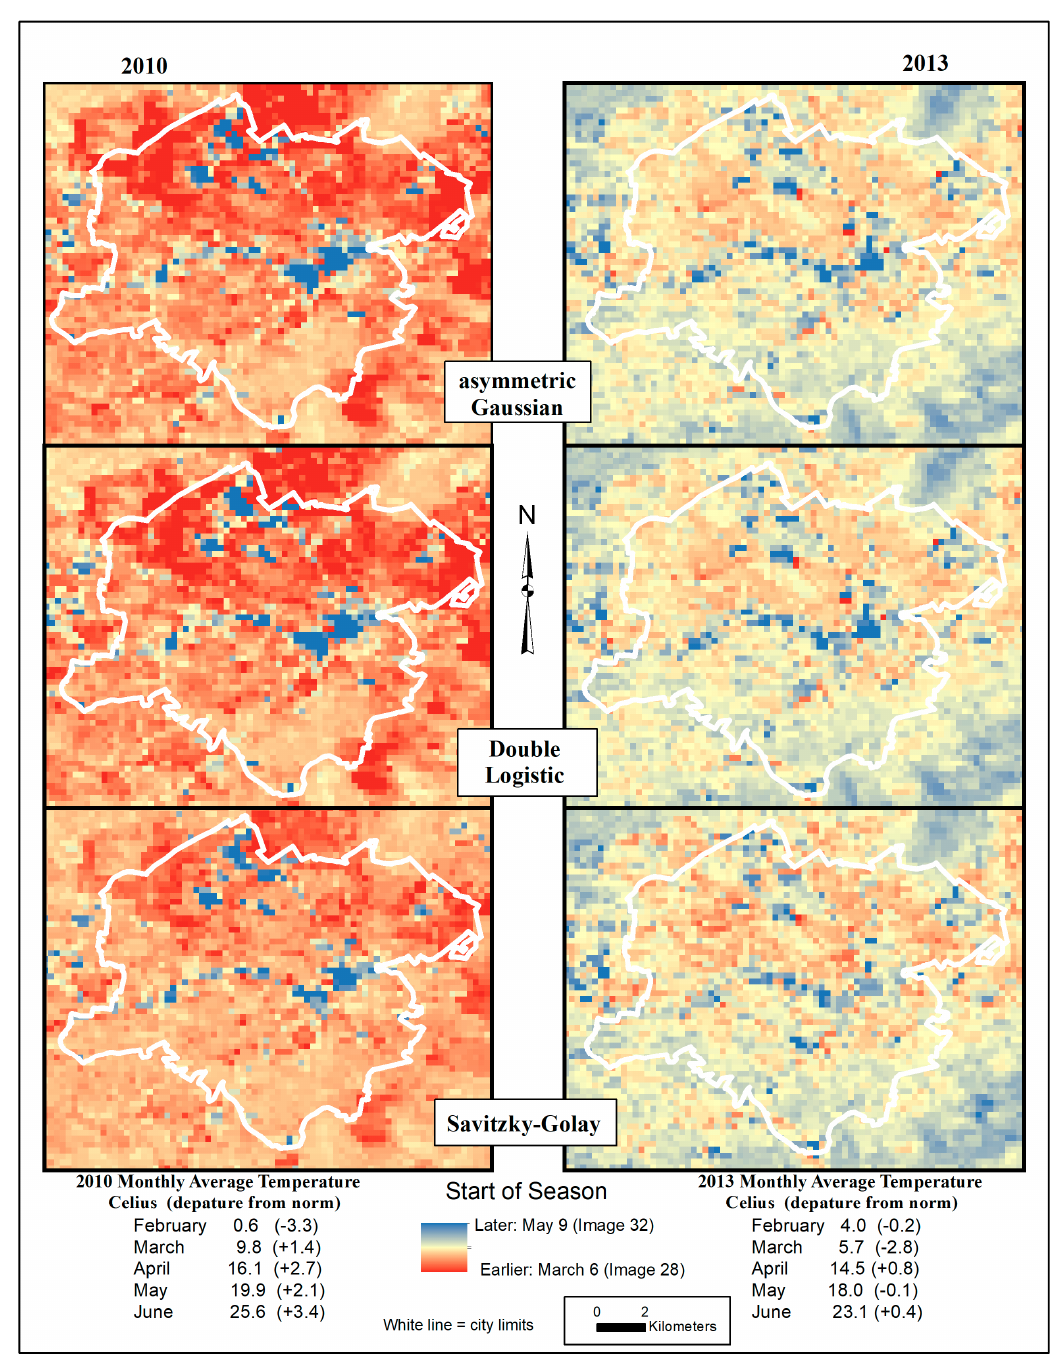
Figure 7. TIMESAT start of season results for each algorithm for two years (2010 and 2013) and average temperatures for the spring of each year. 2010 was warmer than normal, so start of season occurred earlier.